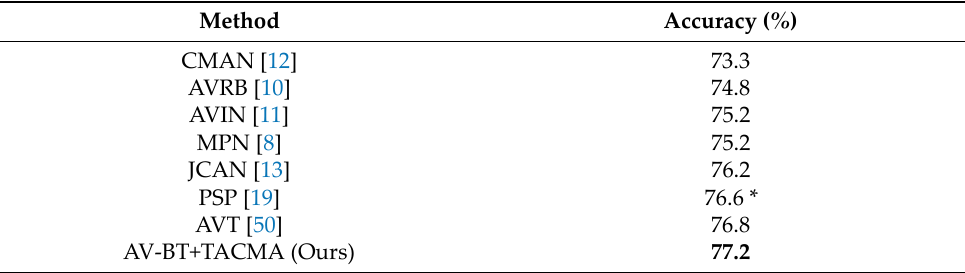
Table 3. Comparing the proposed method to state ‐ of ‐ the ‐ art methods. Our result is in bold.